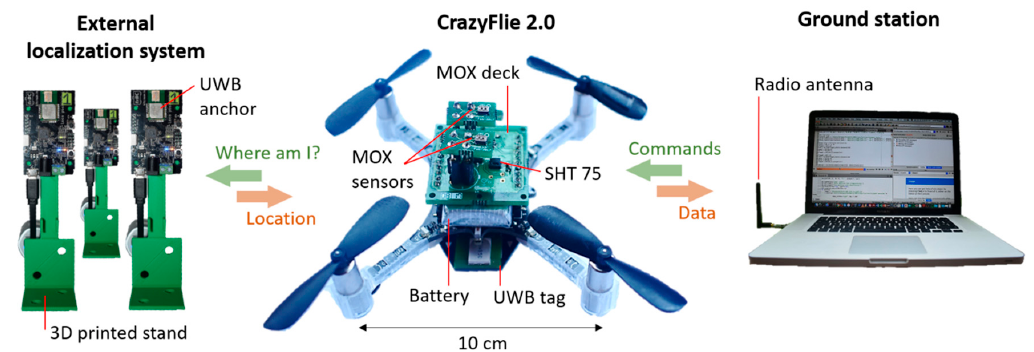
Figure 3. The CrazyFlie 2.0 equipped with the MOX deck and the UWB tag ( center ) gets its 3D position from an external localization system composed of six ultra-wide band anchors ( left ). The location and sensor data are communicated to the ground station ( right ) over the 2.4 GHz ISM band.